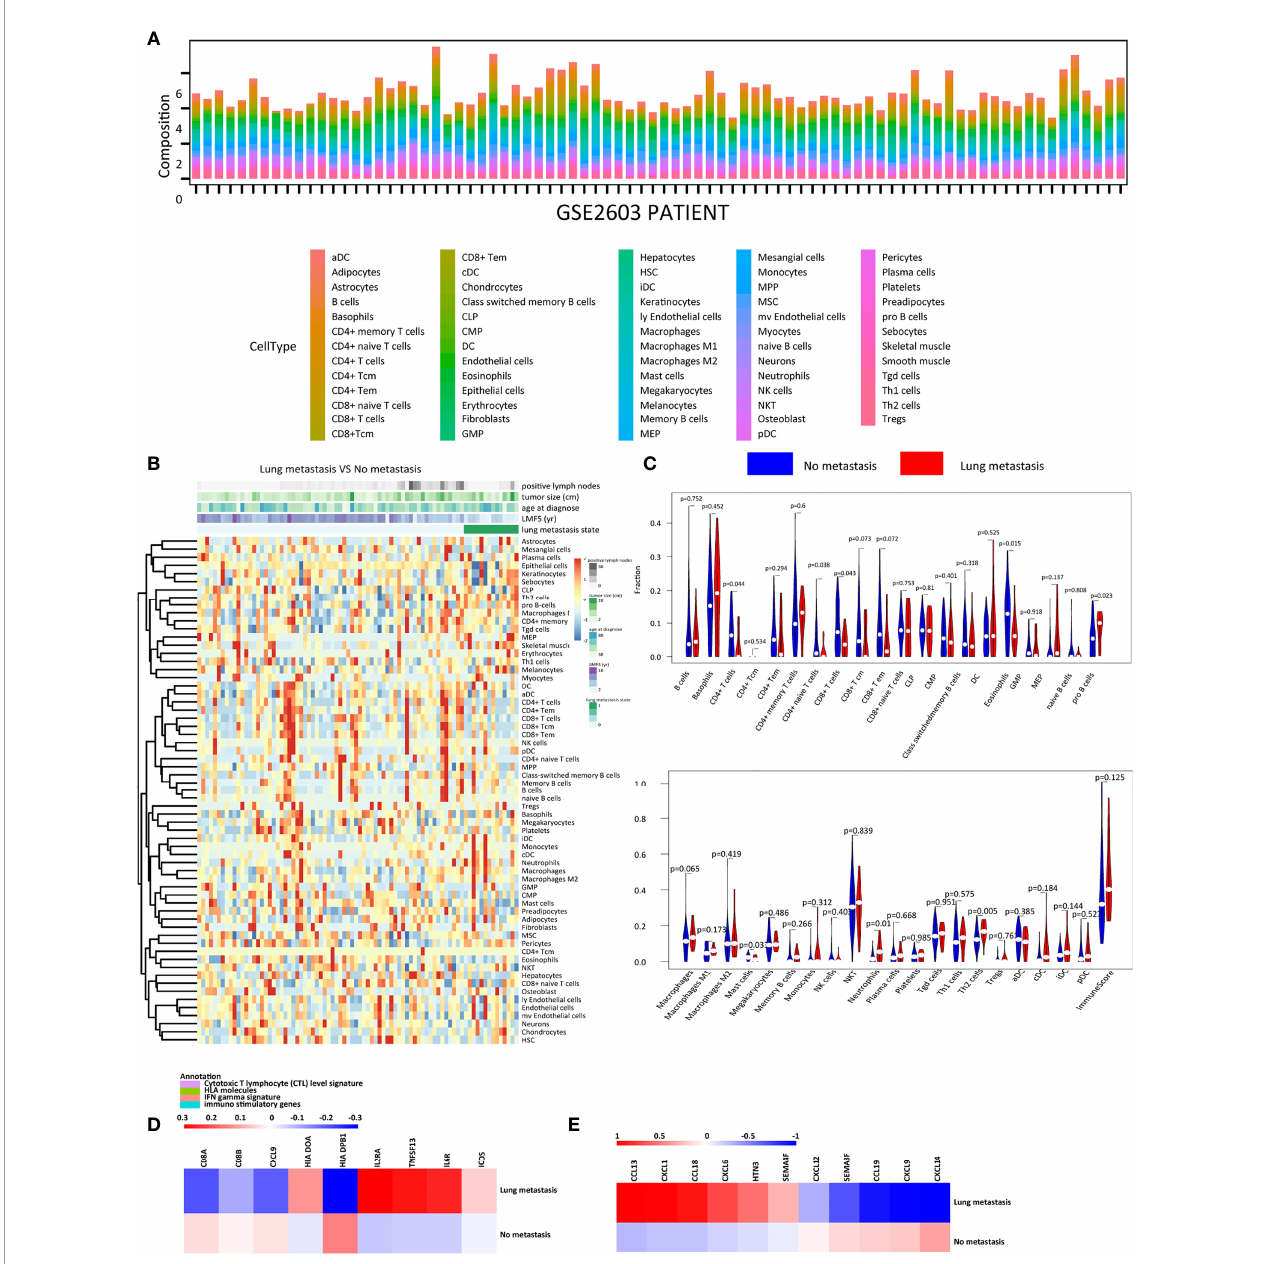
FIGURE 1 | The immune landscape of the GSE2603 cohort. (A) Relative proportions of immune and stromal cell in fi ltrations in no-metastasis and lung-metastasis patients in the GSE2603 cohort. (B) Heatmap of the proportions of 64 cell types in no-metastasis and lung-metastasis patients in the GSE2603 cohort. (C) Violin plot showing the differences of each type of immune cell abundance between no-metastasis patients and lung-metastasis patients. Comparison of the mRNA expression fold changes of (D) cytotoxic T lymphocyte level signature, HLA molecules, IFN gamma signature, immuno-inhibitory genes, immuno-stimulatory genes, and (E) chemokines between no-metastasis and lung-metastasis patients. The fold change is the mRNA relative value to the mean of the whole cohort. Signi fi cantly differentially expressed genes were shown. DC, dendritic cells; MPP, multipotent progenitors; T em , effector memory T cells; CMP, common myeloid progenitors; MEP, megakaryocyte erythroid progenitors; GMP, granulocyte-macrophage progenitors; Tregs, regulatory T cells; HSC, hematopoietic stem cells; T cm , central memory T cells; mv endothelial cells, microvascular endothelial cells; ly endothelial cells, lymphatic endothelial cells; MSC, mesenchymal stem cells; aDC, activated dendritic cells; pDC, plasmacytoid dendritic cells; cDC, conventional dendritic cells; iDC, immature dendritic cells; Th2 cells, type 2 T helper cells; CLP, common lymphoid progenitors; Th1 cells, type 1 T helper cells; NKT, natural killer T cells; Tgd cells, gamma delta T-cells; CTL, cytotoxic T lymphocyte; IFN, interferon; HLA, human leukocyte